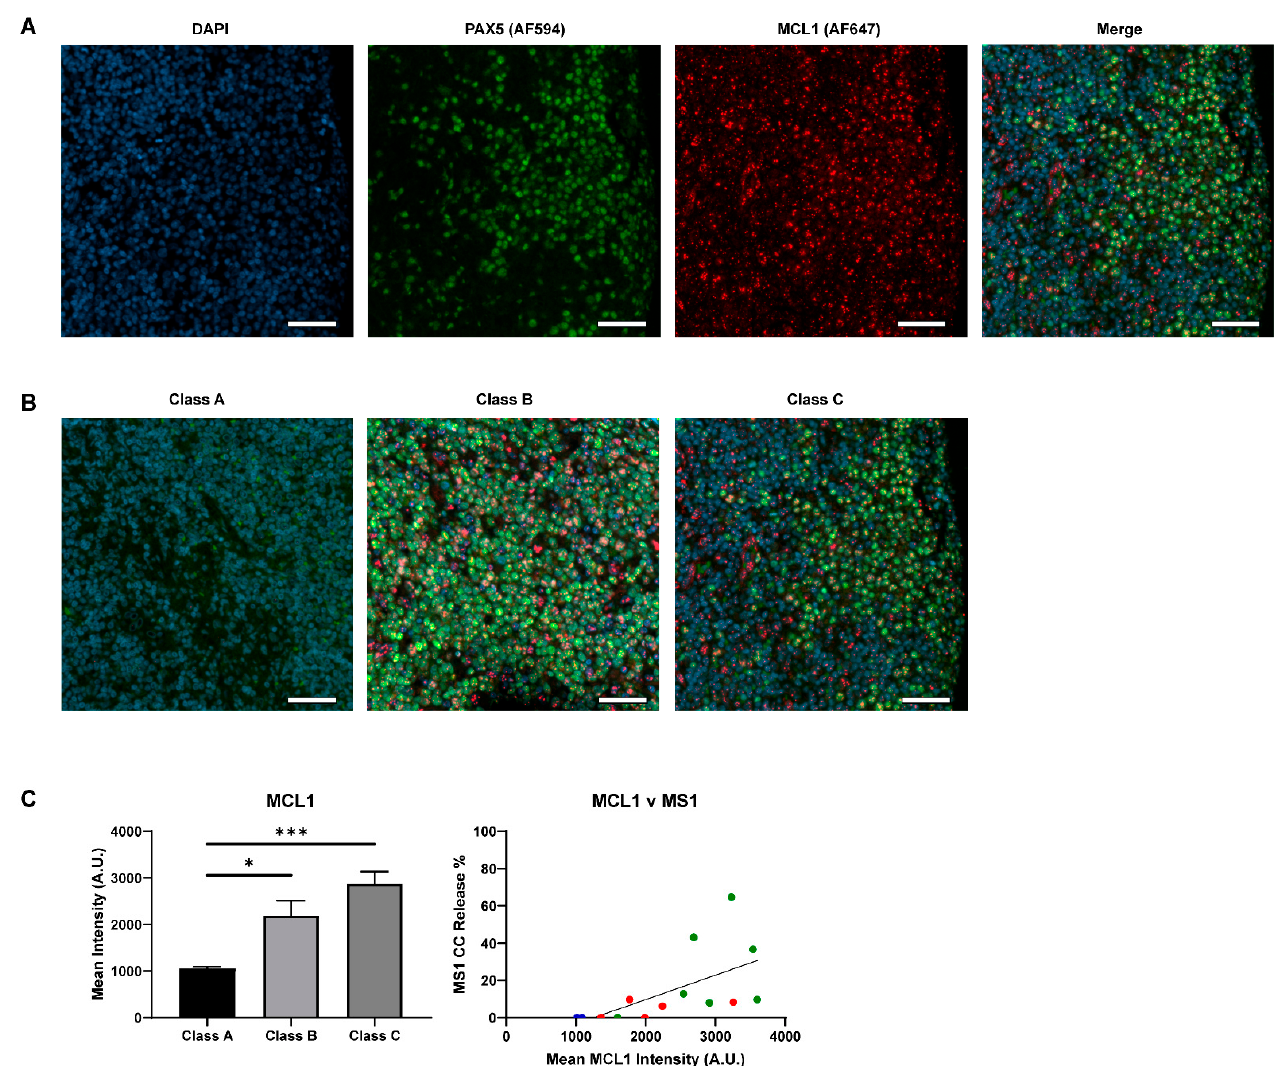
Figure 5. Expression of MCL1 in DLBCL by immunofluorescence. ( A ) Representative 20× single channel images of DAPI (blue), PAX5 (green, AF594), and MCL1 (red, AF647), as well as a merged image, in a class C sample. Scale bars represent 50 µm. ( B ) Qualitative comparison of MCL1 expression in class A, B, and C samples. The same sample from panel A is used in this panel. PAX5 staining was weak in class A when co-stained with MCL1, but this tissue was confirmed to be PAX5 positive in previous stains. Scale bars represent 50 µm. ( C ) The mean pixel intensity of all samples in each class, as calculated by Qupath. T-test with Welch’s correction was used to compare columns, bars represent the mean ± standard error of the mean (SEM). Spearman linear regression analysis was applied to analyze the correlation between cytochrome c release to MS1 (10 µM) and mean MCL1 intensity ( R 2 = 0.3525). Dot colors represent class of sample: A (blue), B (red), C (green). Response was only seen in class C samples with high MCL1 expression and mean MCL1 expression was lower in Class A/B samples * p < 0.05, *** p < 0.001.